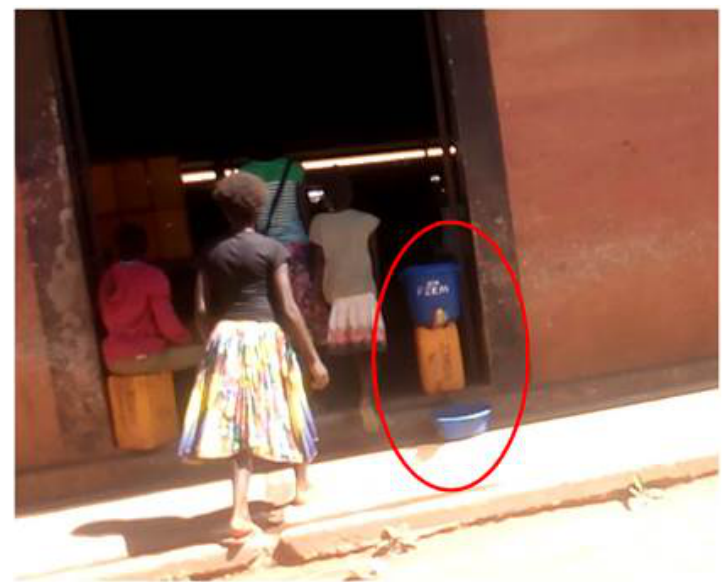
Figure 1. Hand-washing device (in red solid circle) in a public market in Lubumbashi, Democratic Republic of Congo.